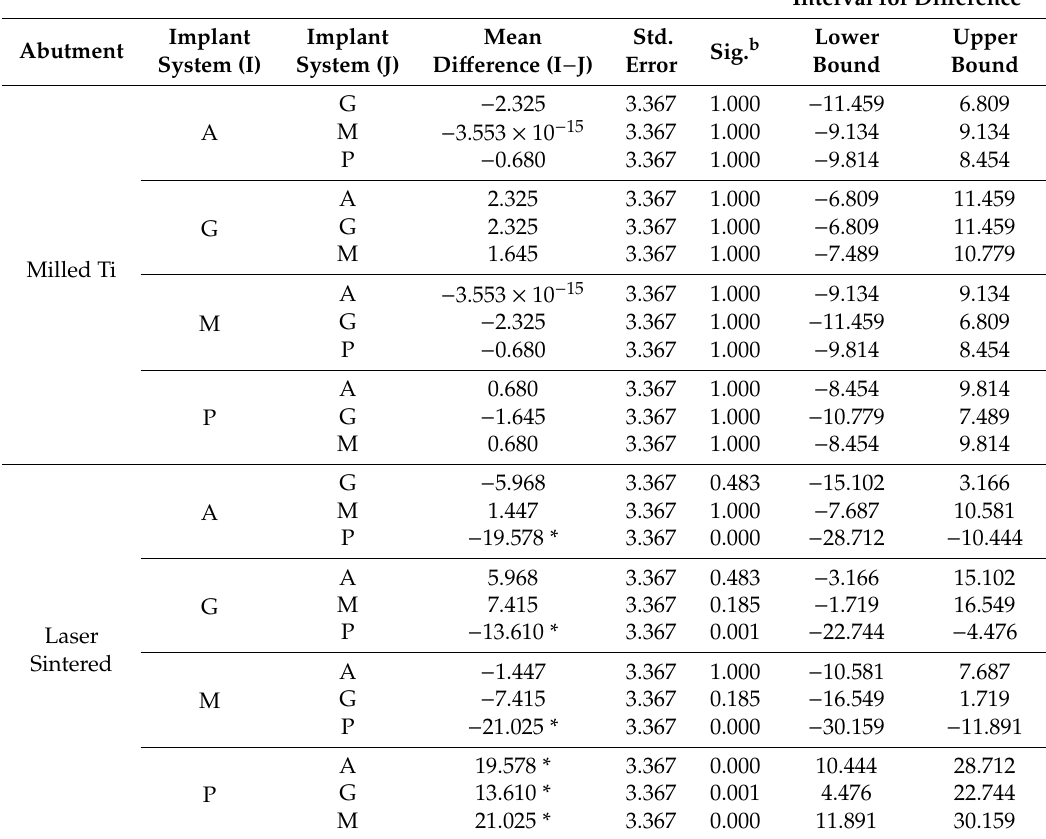
Figure 4. Graph of misfit values among the groups. Table 5. Pairwise comparisons. Dependent Variable: Marginal Discrepancy